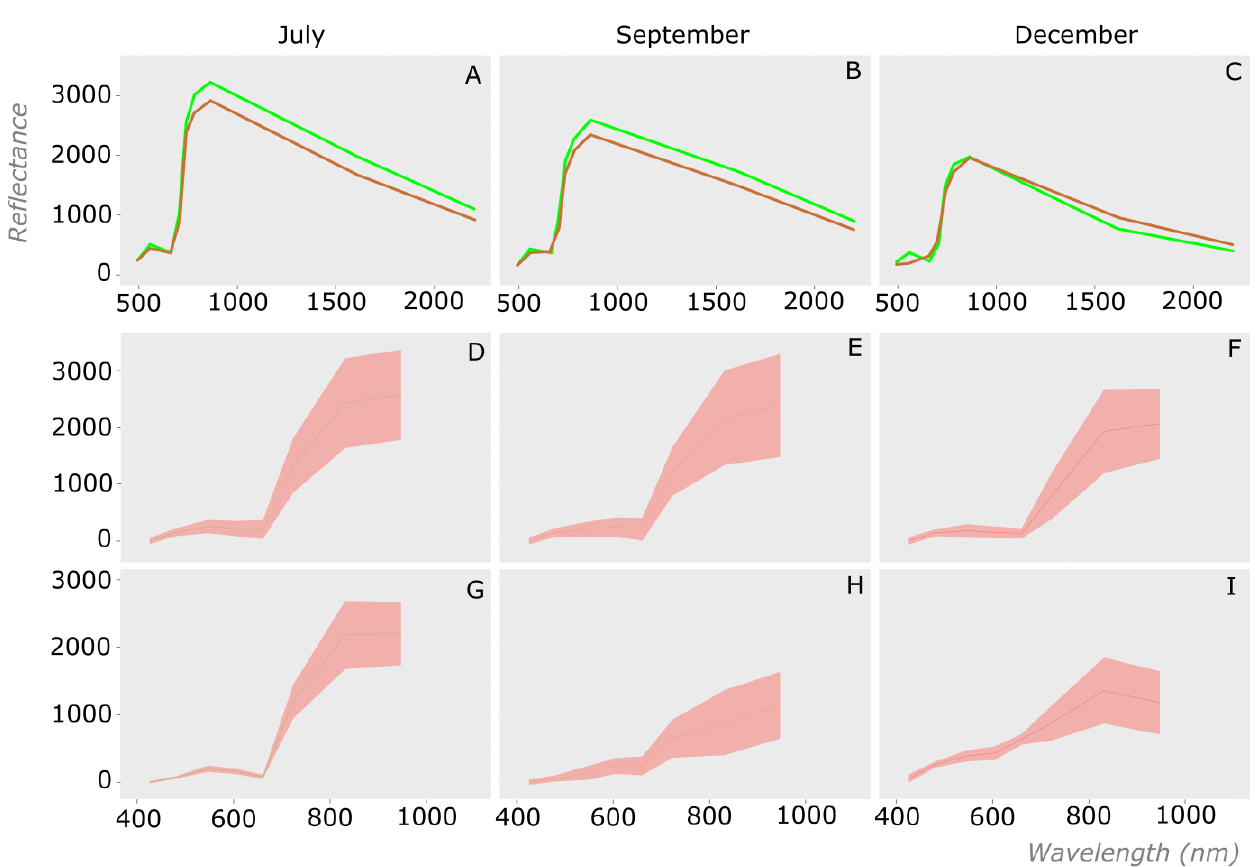
Figure 5. Representative comparison of WorldView-3 (average) and Sentinel-2 (pixel) spectra for different percentages of decline cover across 3 key months in the wilting season (pre, -mid, and late-season). ( A – C ) Sentinel-2 reflectance for a pixel with 0% (green) and 43% (brown) canopy cover in decline. ( D – F ) Median WorldView-3 reflectance within the area covered by the Sentinel-2 pixel with healthy maritime pine trees. ( G – I ) Median WorldView-3 reflectance within the area covered by the Sentinel-2 pixel with declining maritime pine trees (43%) (Sentinel-2 and Worldview-3 imagery have different spectral